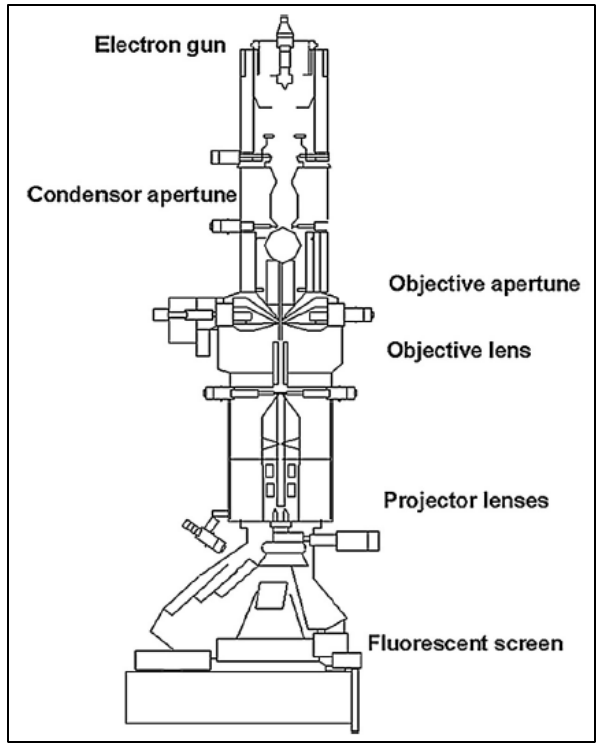
Figure 6. Components of transmission electron microscopy (TEM) instrument [32].